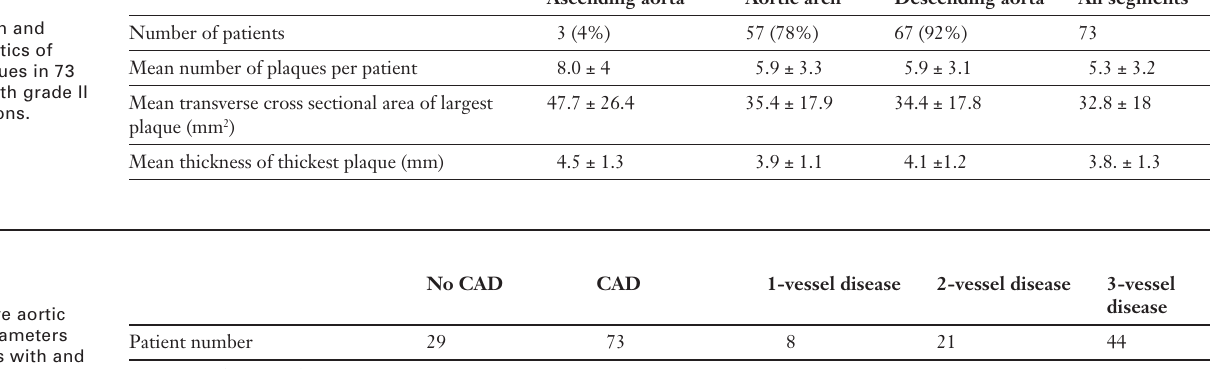
Quantitative aortic plaque parameters for patients with and without CAD.